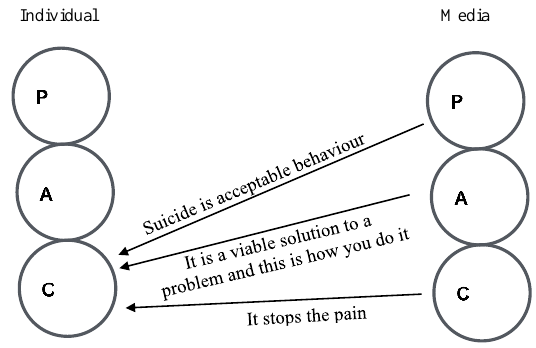
Figure 3: Suicide reported in the